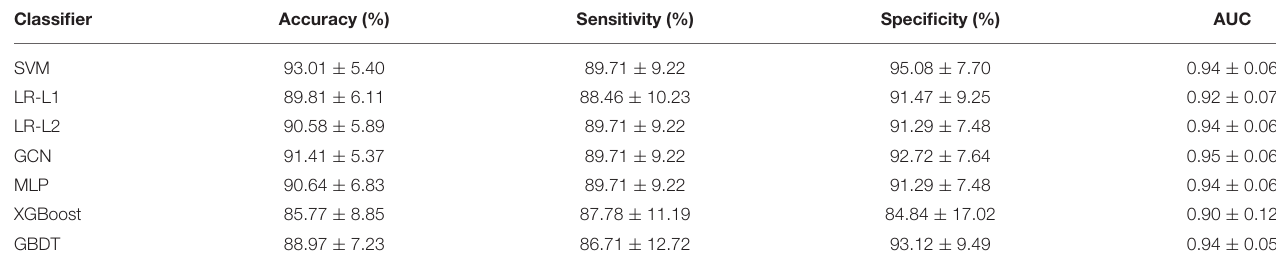
TABLE 4 | Results of classification for the data of